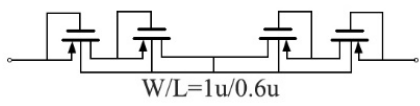
Figure 7. The pseudo resistor used for R p 2